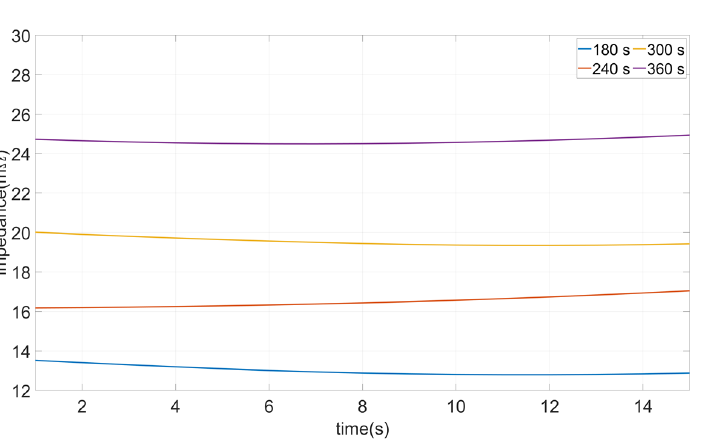
Figure 6. Resistance–time diagram of the case study of 2nd Incheon line using TPS with varying headway.